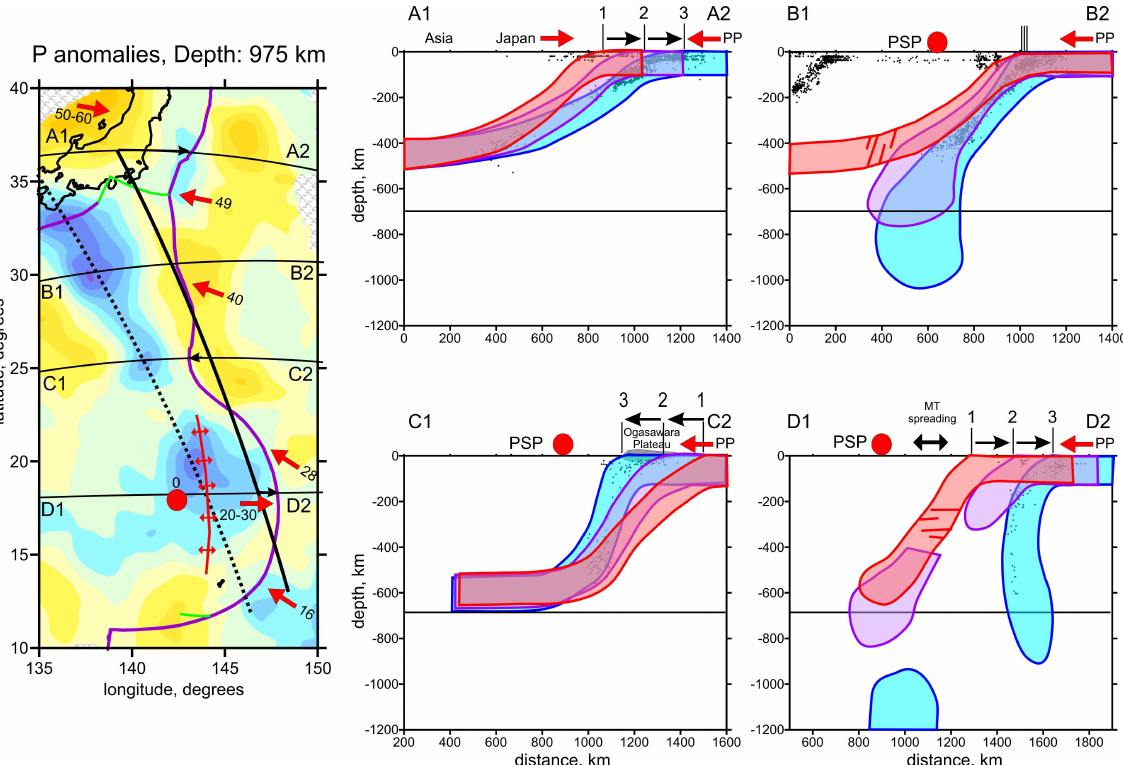
Fig. 9. Reconstruction of the subduction evolution in different segments of the Izu-Bonin and Mariana arcs. Left: map view of the area. Violet line is the present location of the trench; black line is a possible location of the trench about 12Ma; dotted line is a possible location of the slab material at about 1000km depth, background is P-velocity anomalies at 975 km depth; location of profiles for schematic representation are shown. Right: different regimes of subduction in four different segments of the arc. Color of patterns corresponds to the age: red is ∼ 12Ma, violet is ∼ 6Ma and blue is present. Bars with nimbers 1, 2 and 3 correspond to the location of the trench in the three episodes. Black dots depict the present seismicity around the corresponding segment; solid line is the boundary between the upper and lower mantle. PSP is the Philippine Sea Plate, PP is the Pacific Plate, MT is the Mariana trough. Red dot indicates the reference point on the Philippine Sea Plate. Directions of displacements relative to PSP are shown with red arrows and numbers in